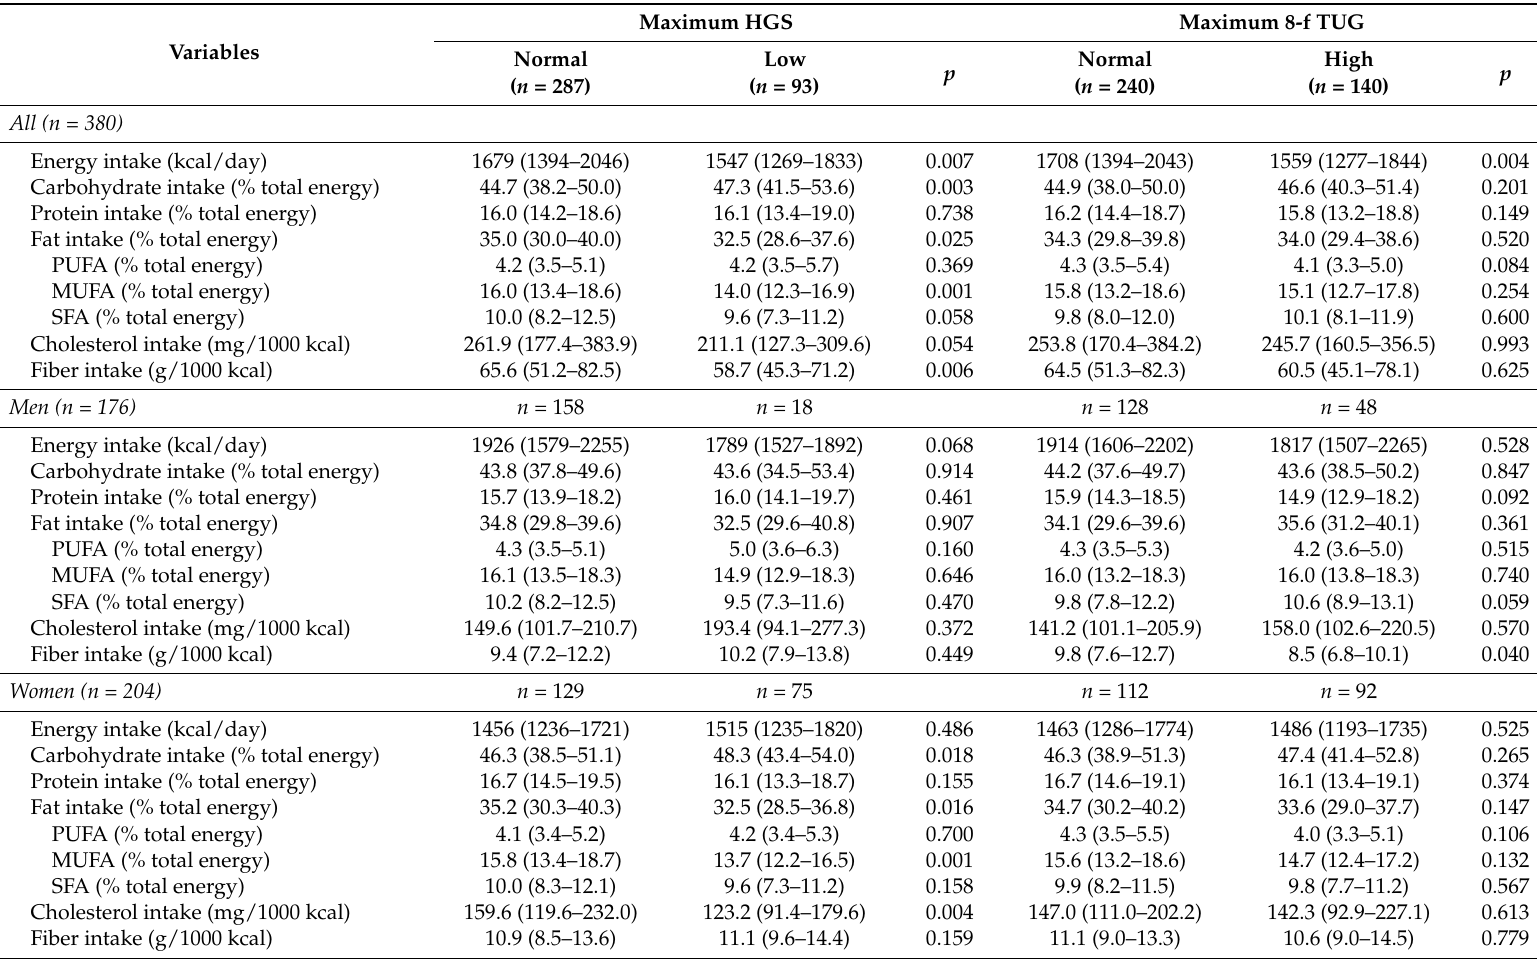
Table 3. Energy and macronutrient intake according to low/normal HGS and high/normal 8-f TUG